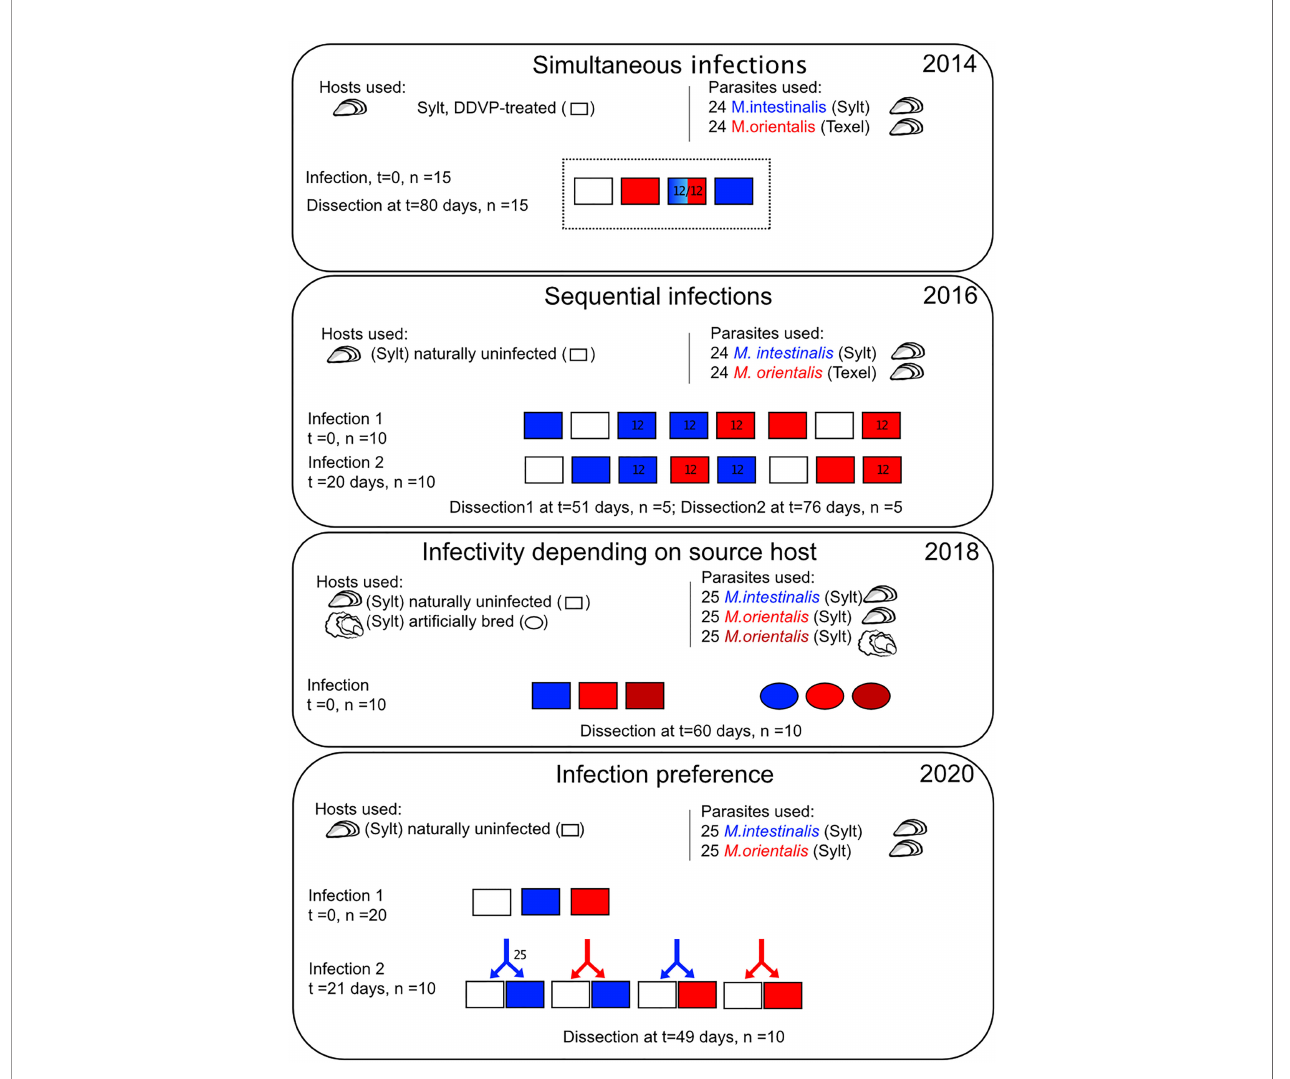
FIGURE 2 | Schematic representation of the experimental infections. Each panel shows one experimental setup and the year in which the experiment was conducted. Boxes represent batches of experimental mussel and ovals batches of oyster hosts with blue coding for infections by M. intestinalis , red for infections by M. orientalis originating from mussels, and dark red for M. orientalis originating from oysters. Batch size is given by the n for each experiment. The geographic source of hosts and parasites is shown in brackets and source hosts are shown by